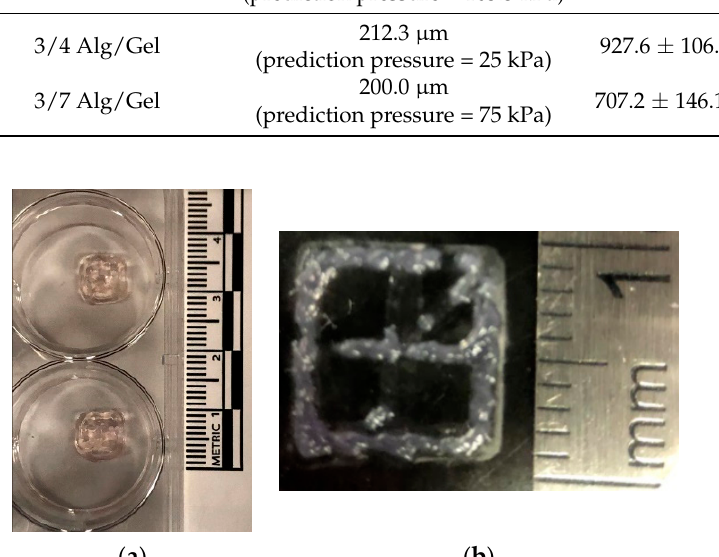
Figure 8. Constructs directly after printing onto tissue-culture treated well plate surfaces ( a ) 3/4 Alg/Gel and ( b ) 3/7 Alg/Gel. The scale in both pictures is 1 cm per unit length.